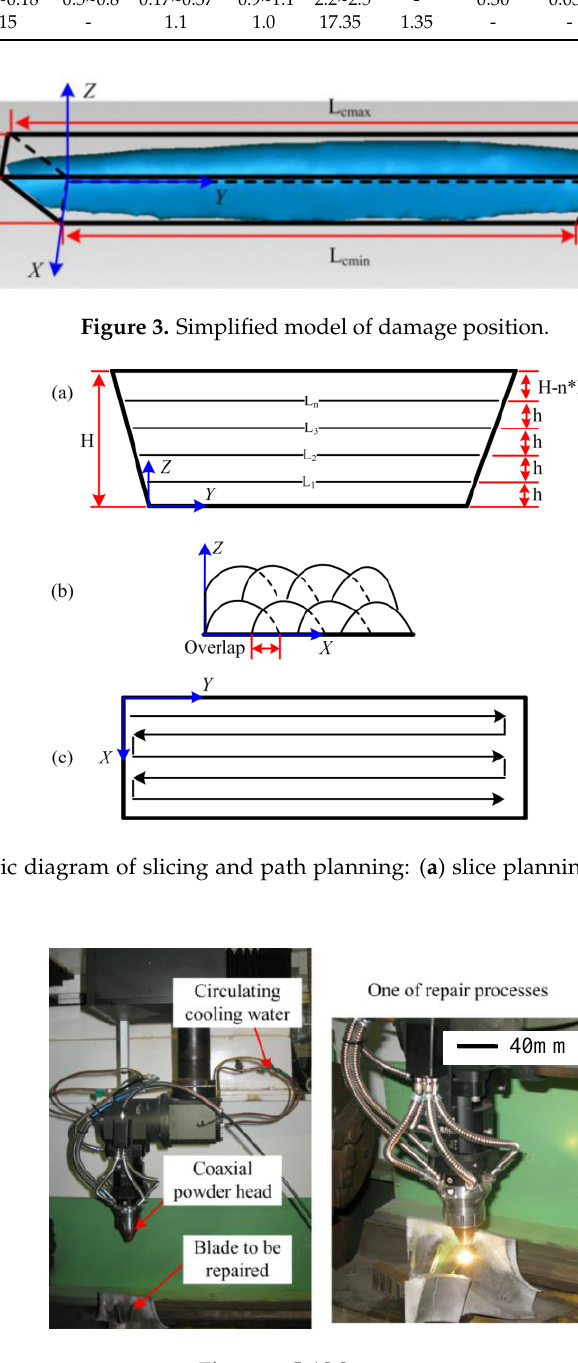
Figure 5. LAM process.